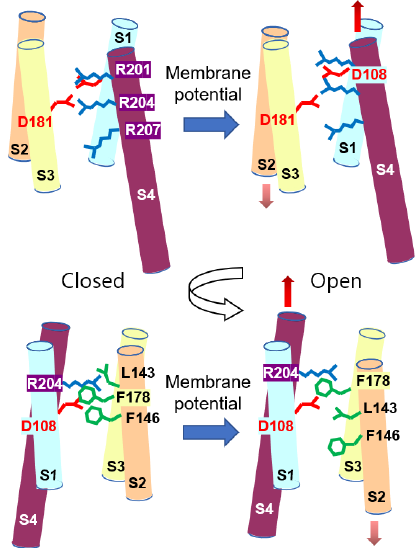
Figure 8. Proposed gating mechanism of Hv1 voltage ‐ gated proton